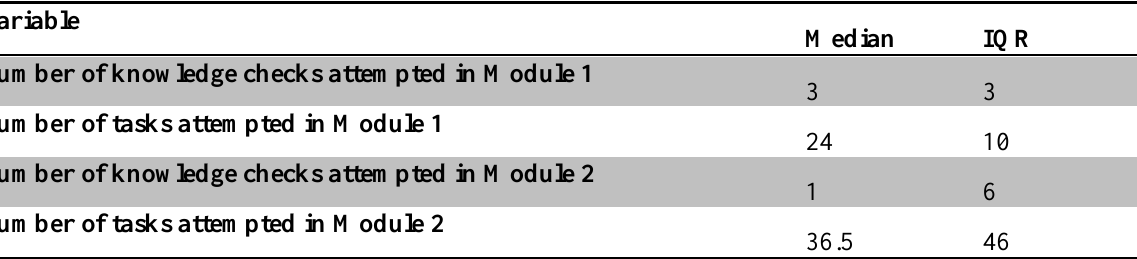
Table 2: Median and interquartile range for distribution of task and knowledge check attempts in Modules 1 and 2